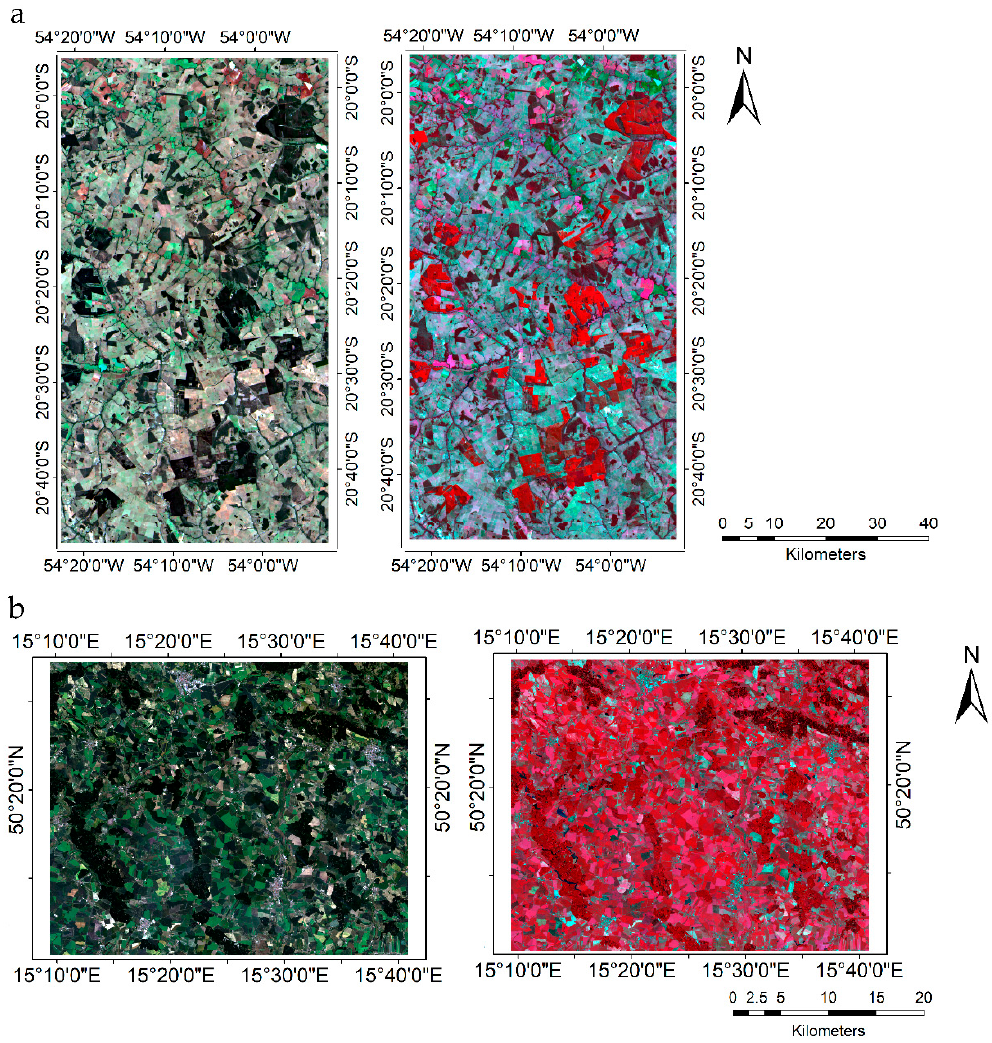
Figure 3. Areas used for sharpening and NDVI calibration in natural and false colors. ( a ) Site 1, image collected on 13 July, 2017, and ( b ) Site 2, image collected on 20 June, 2017. collected on 13 July, 2017, and ( b ) Site 2, image collected on 20 June,